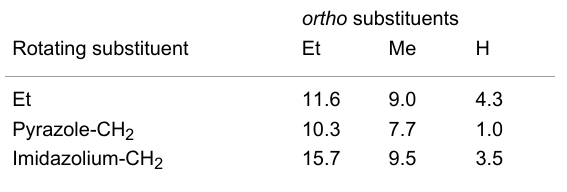
Table 7: Calculated energy barriers (kcal/mol) to bond rotation, with respect to the rotating functional group and neighboring substituents. ortho